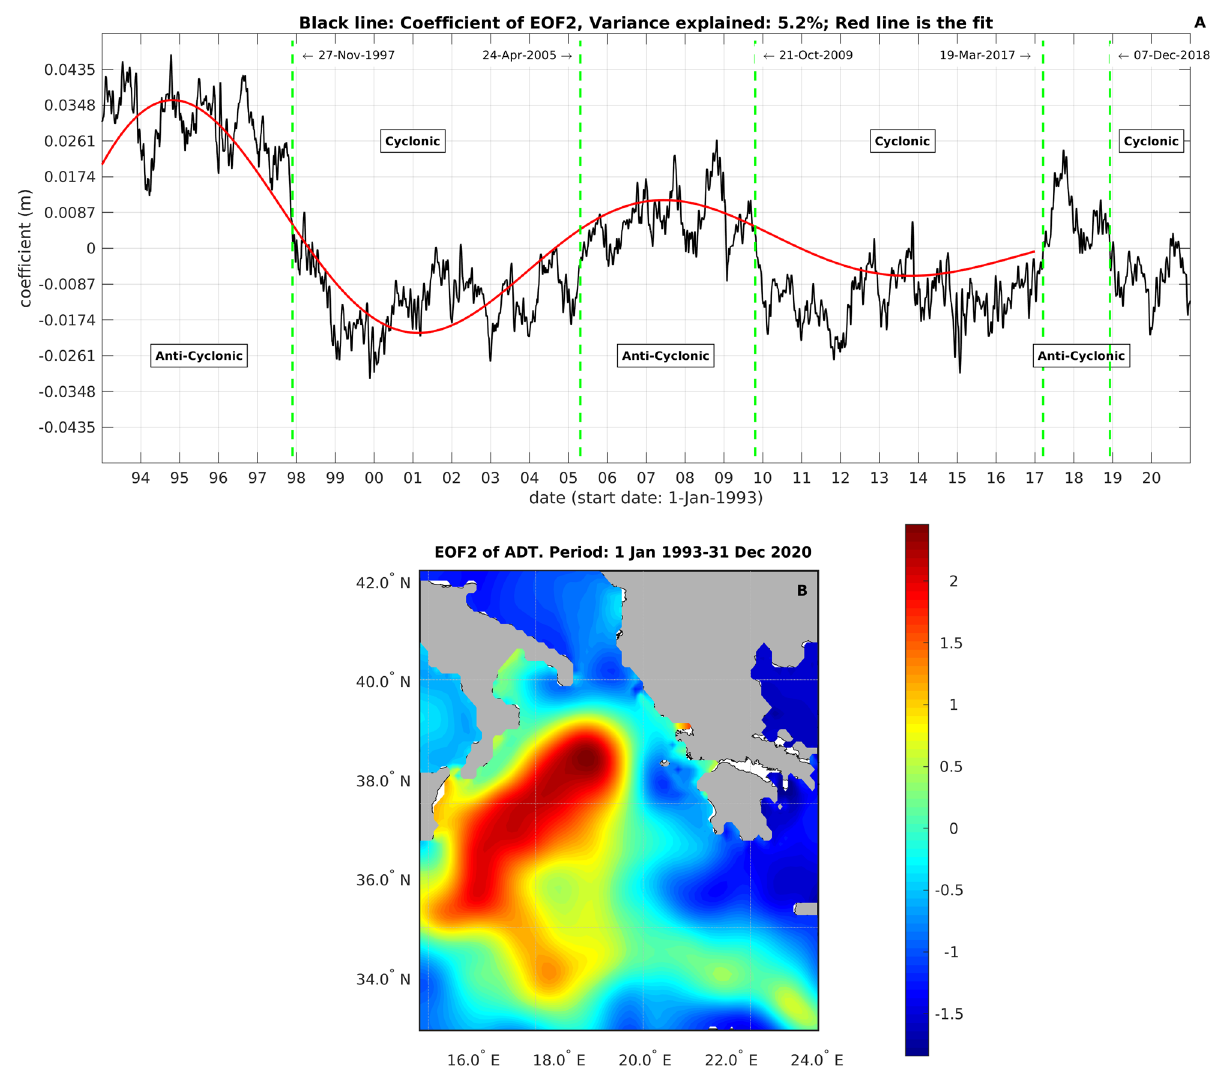
Figure 2. Empirical Orthogonal Function analysis of SSH. ( A ) the black line represents the coefficient of EOF2, the red line its fit to the function e −( t / τ ) cos( 2π · t / T + φ ); fitted values are: T = 12.6 years, τ = 11.3 years. ( B ) the second EOF mode. This figure has been created using MATLAB software package version 2018a (www. mathw orks.